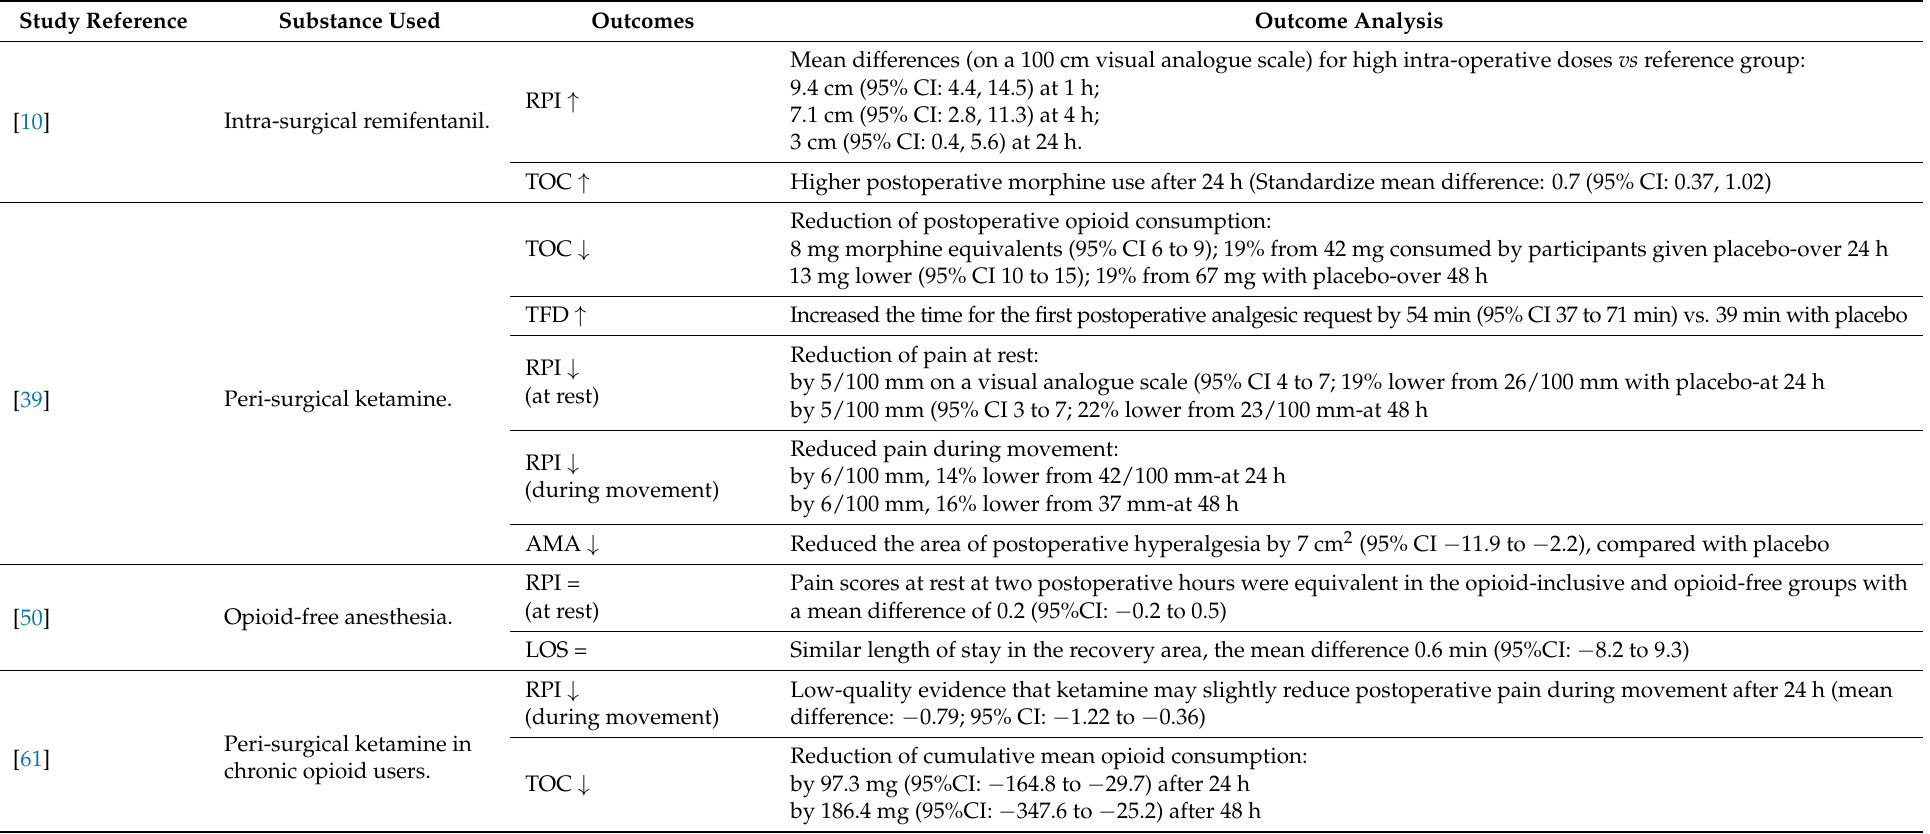
Table 3. Evidence gathered from meta-analysis implicating OIH occurrence and treatment in surgical settings. Study Reference